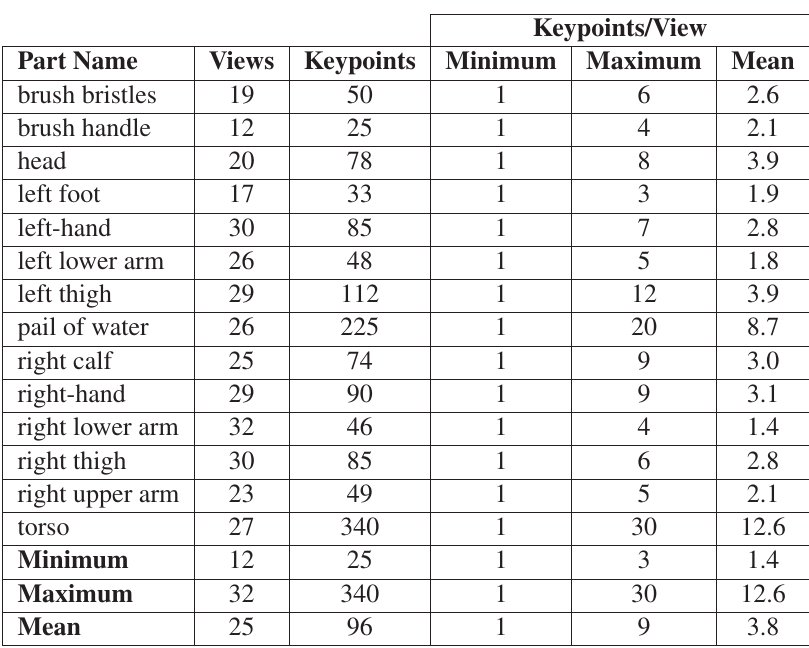
Table 3. SIFT keypoint database (Parts Database)